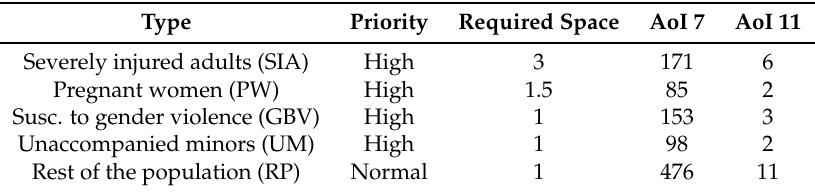
Table 3. Population characteristics.